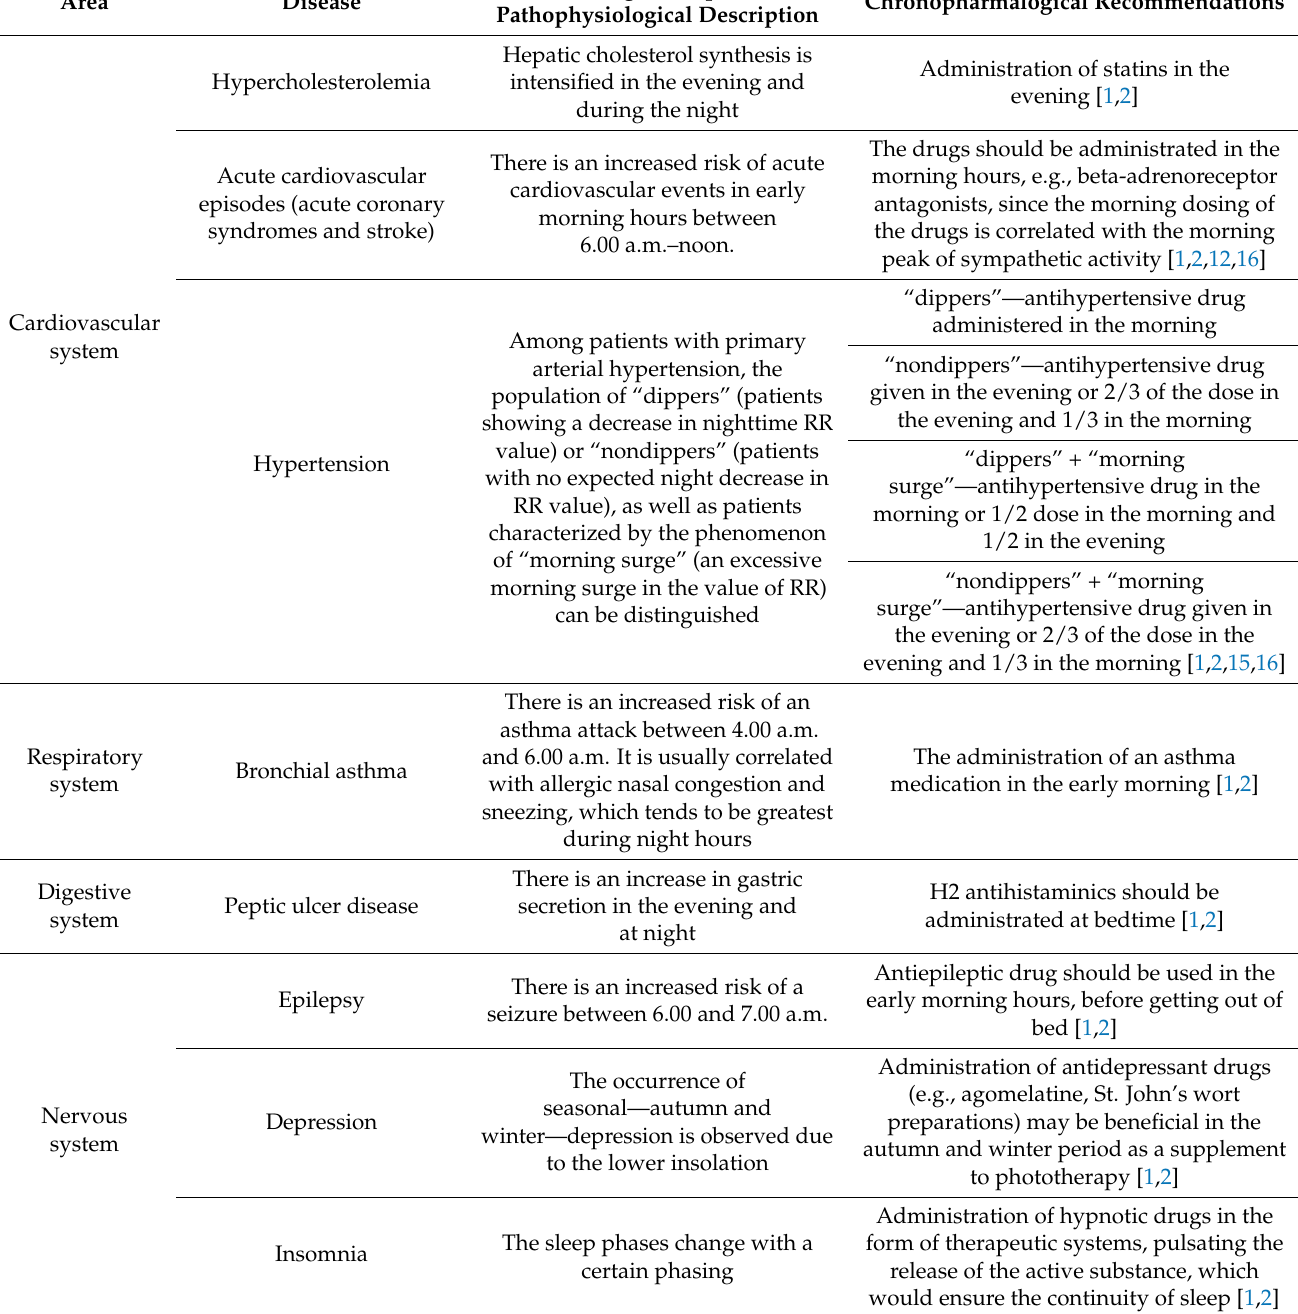
Table 1. The examples of pharmacotherapy in line with chronopharmacological recommendations.